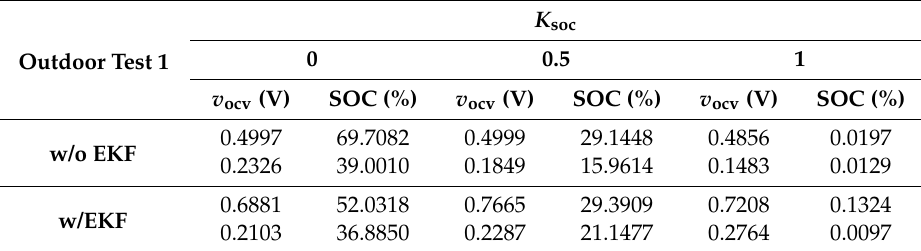
Table 2. Outdoor test result (0 kg